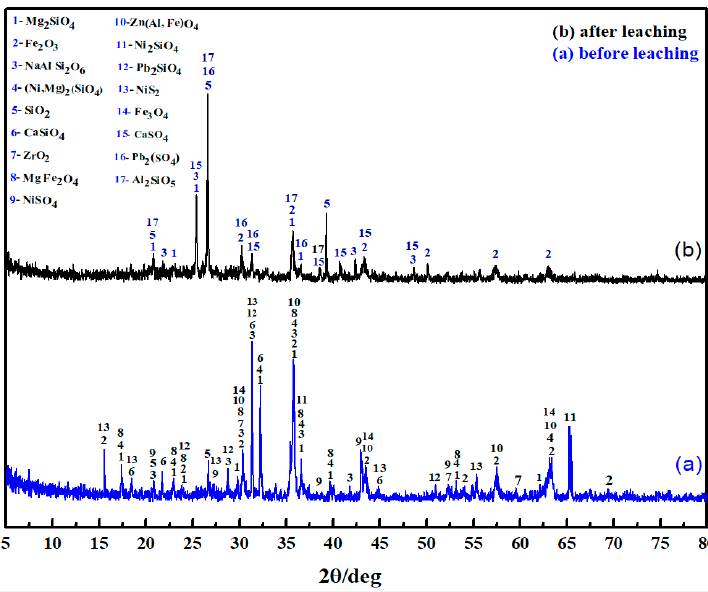
Figure 1. XRD patterns of water leaching solid residue (WLSR) of boiler ash (a) before and (b) after leaching with H 2 SO 4 at the optimum operating conditions.